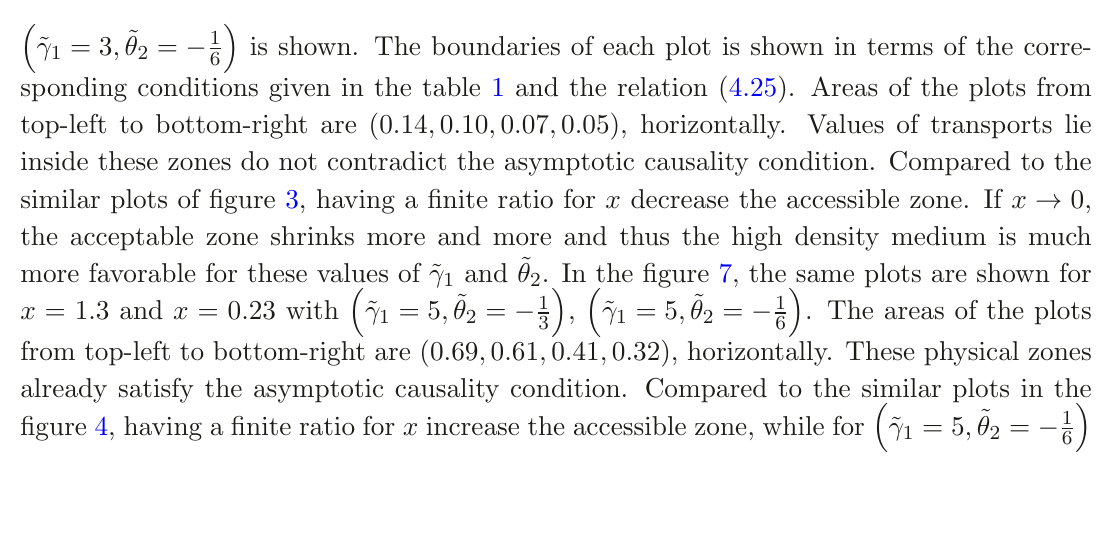
. The areas of the